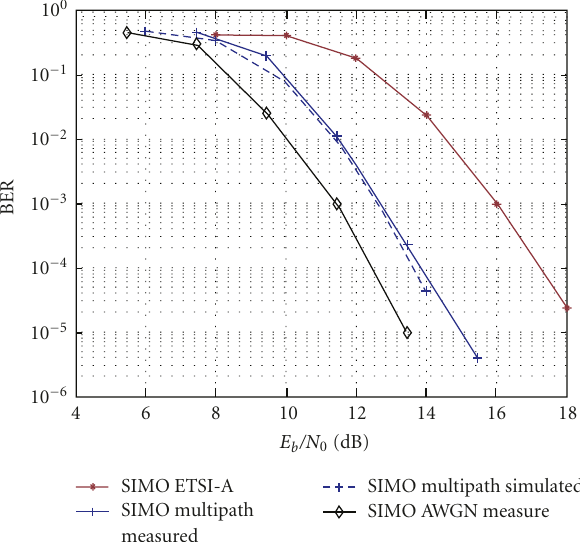
Figure 11: BER versus E b / N o for an 802.11b transmission with one or two received antennas in an AWGN channel.